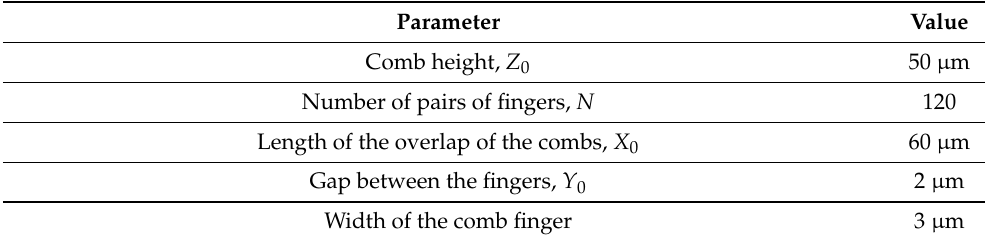
Table 4. Parameters of the comb counter-pin